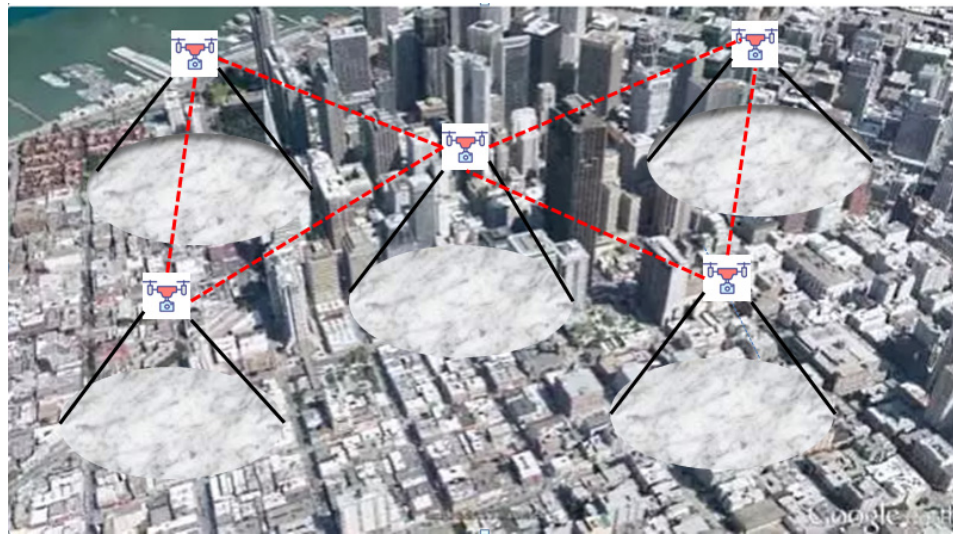
Figure 4. UAVs serving as aerial adhoc base stations.